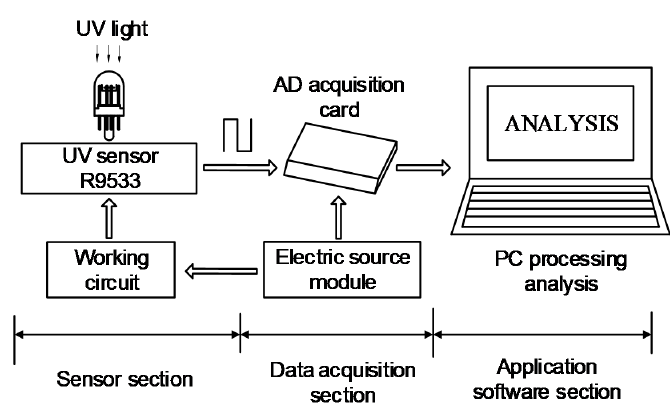
Figure 1. Block diagram of the UV Pulse Detection System hardware.